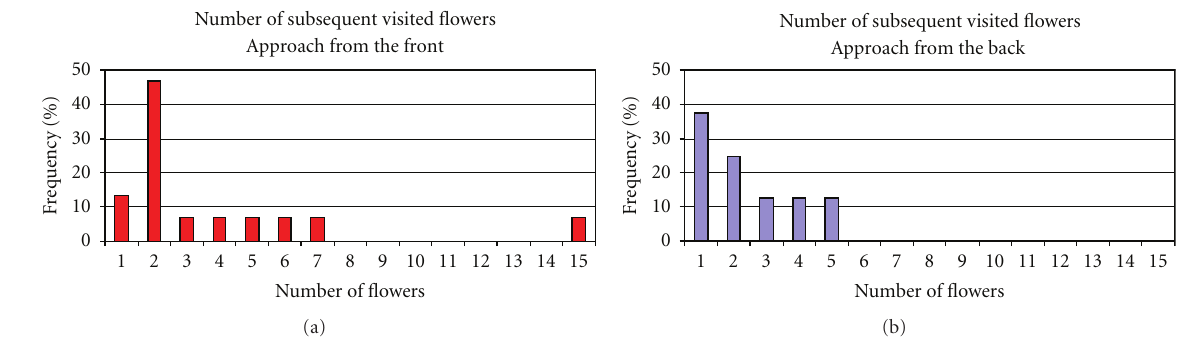
Figure 8: Number of C. emerus flowers subsequently visited by the same insect. (a) Insects approaching the flowers from the front. (b) Insects approaching the flowers from the back.